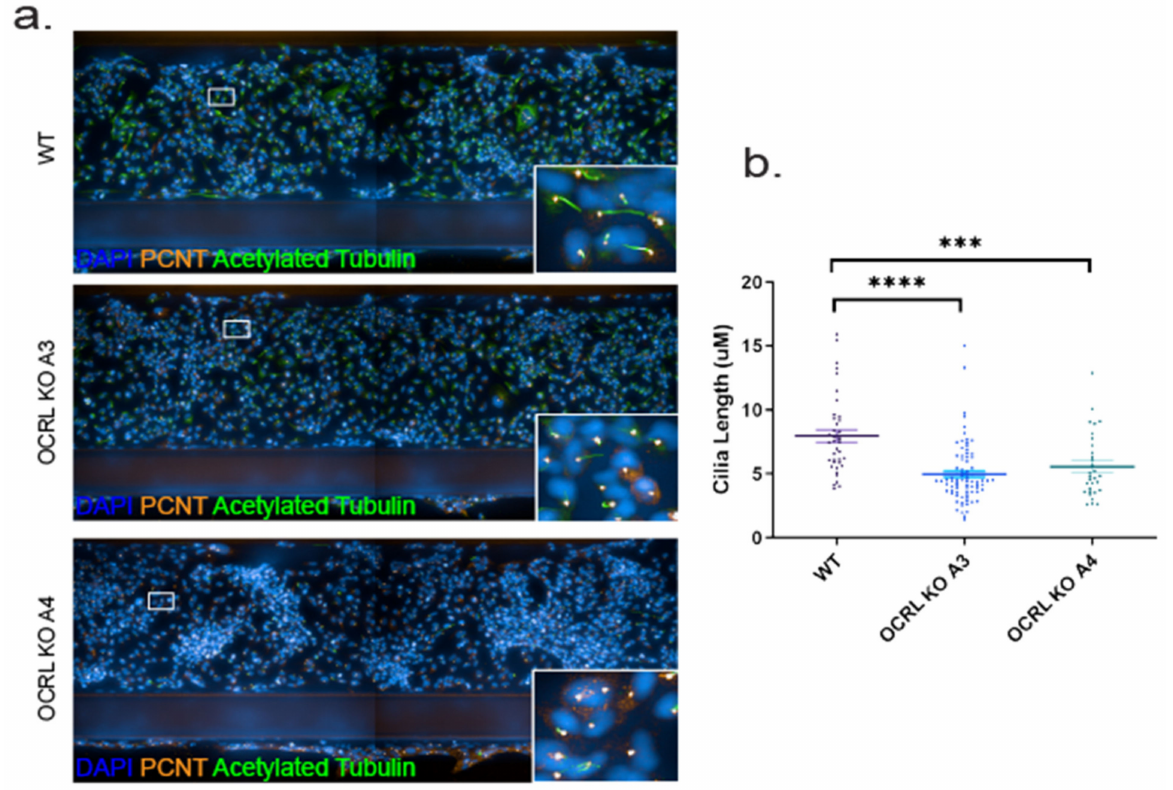
Figure 4. Cilia defect in Lowe syndrome cells under fluid flow: ( a ) immunofluorescence images showing HK-2 cells (WT and OCRL KO (A3, A4)) grown in OrganoPlate and stained with acetylated tubulin and PCNT to visualise primary cilia (green) and pericentrin (orange), respectively. Images were captured using the Perkin Elmer Operetta CLS with 20X water objective. Two adjacent fields were stitched together for visual purposes of the tubule. ( b ) Quantitative analysis of cilia length measured using segmented tool in ImageJ software and represented as a scatter plot with individual values. Ordinary one-way ANOVA and Dunnett’s multiple comparison test, N = 3 (>50 cells per N ). ***, p < 0.001; ****, p < 0.0001, error bar represents mean with ±